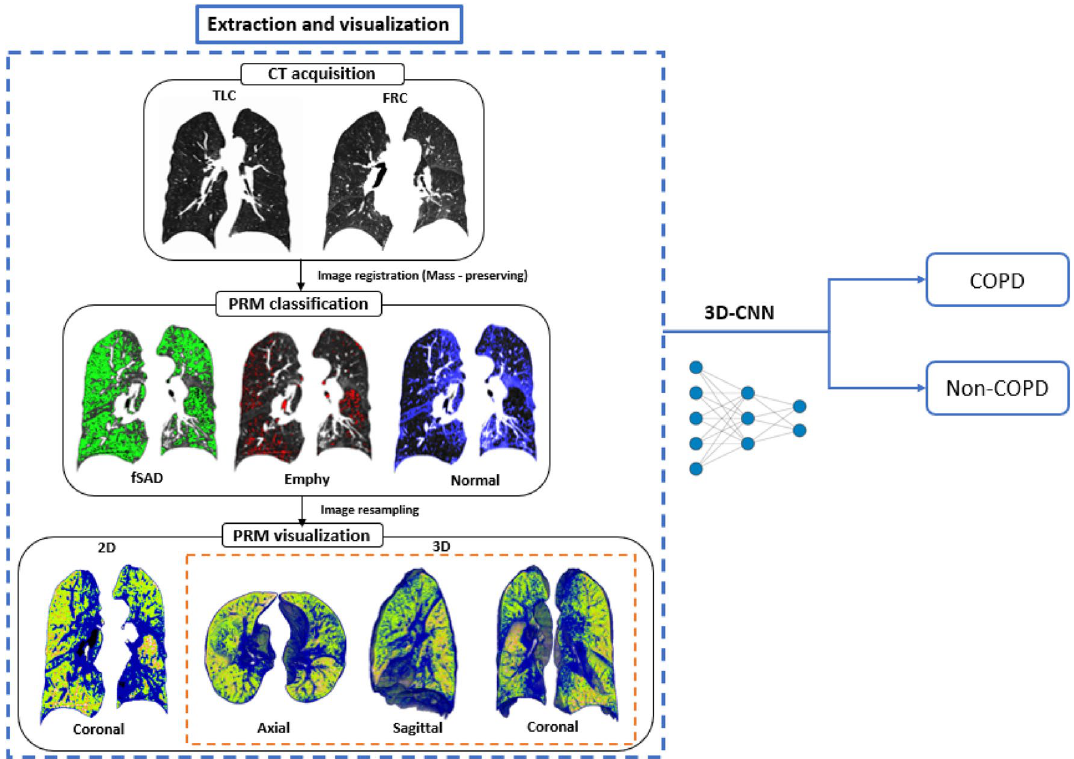
Figure 1. Study design and main experimental produces of 3D-cPRM, operating on a subject with stage III COPD. This figure was generated with ImageJ (version 1.53a, https ://image j.net/) and Microsoft PowerPoint 2010 (version 13328.20292; https ://www.micro soft.com).